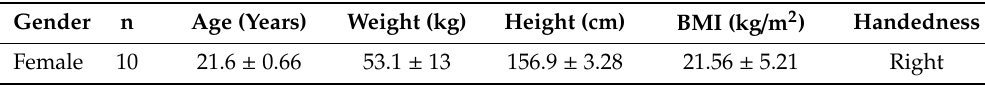
Table 5. Baseline characteristics for sleep onset latency study. Data are shown as mean ±